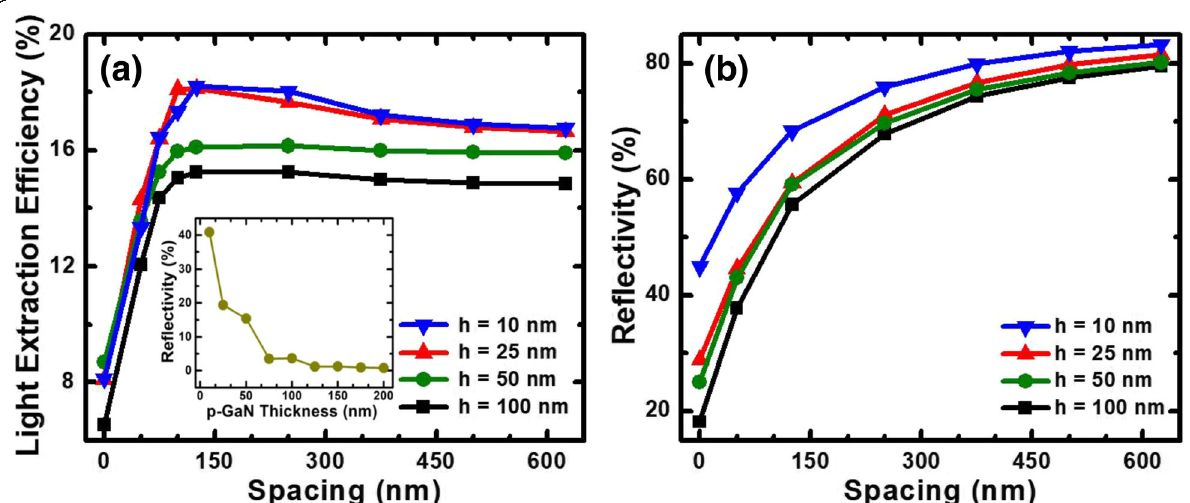
Fig. 4 ( a) LEEs as a function of the nanorod spacing for DUV LED with Al reflector and with the p-GaN nanorod heights of 10, 25, 50, and 100 nm are set. Inset: reflectivity of normal incidence for conventional DUV LED as a function of the p-GaN layer thickness and b reflectivity of normal incidence as a function of the nanorod spacing when the p-GaN nanorod heights are of 10, 25, 50, and 100